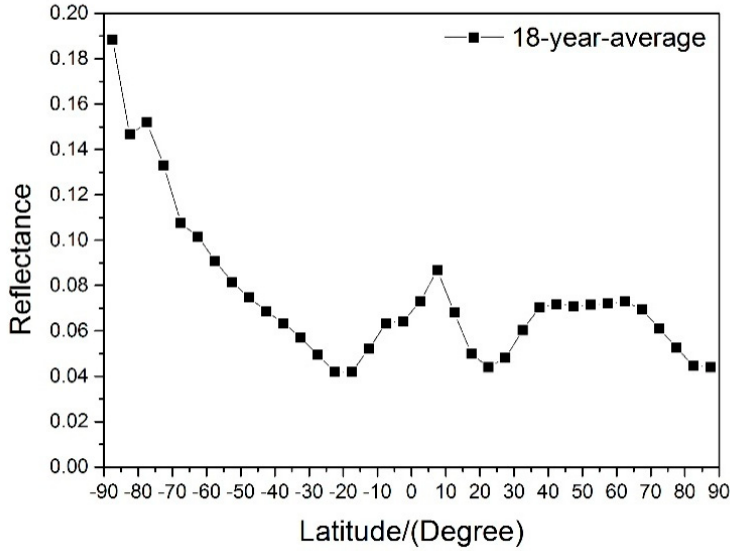
Figure 2. The 18-year average cirrus reflectance vs. latitude and longitude.